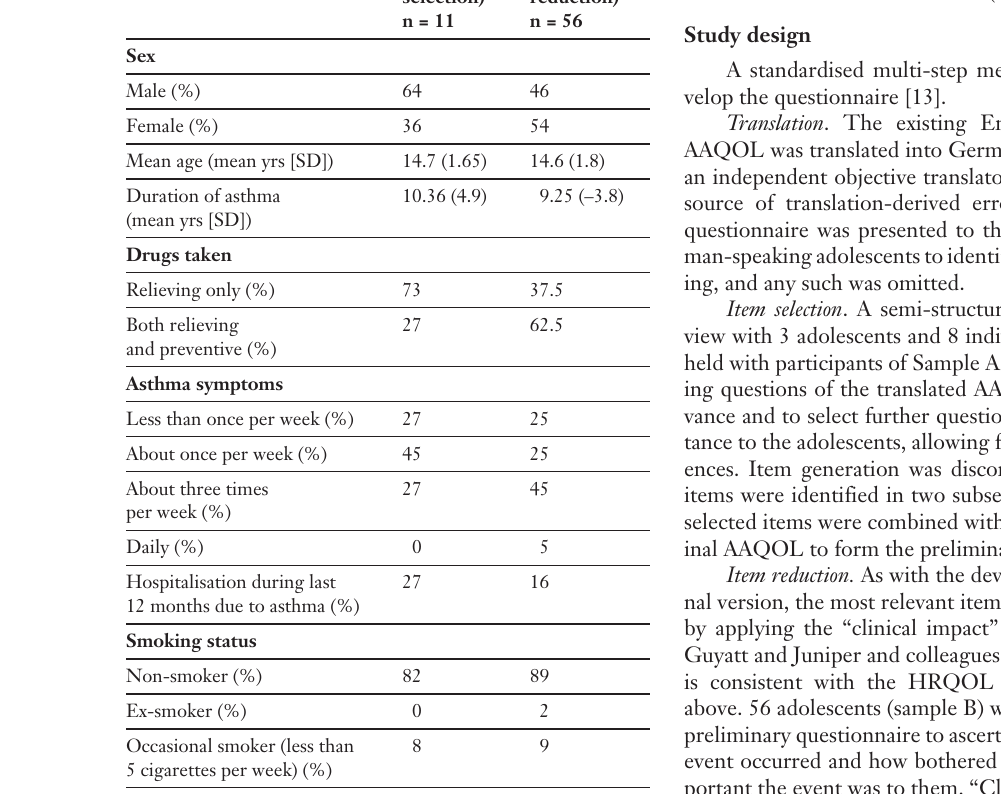
Demographic charac-